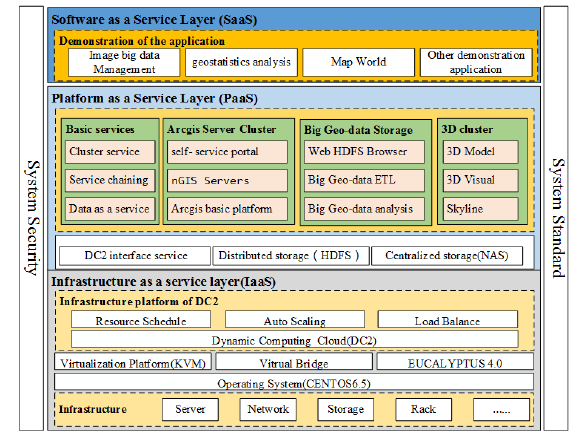
Figure 1. Spatiotemporal cloud platform